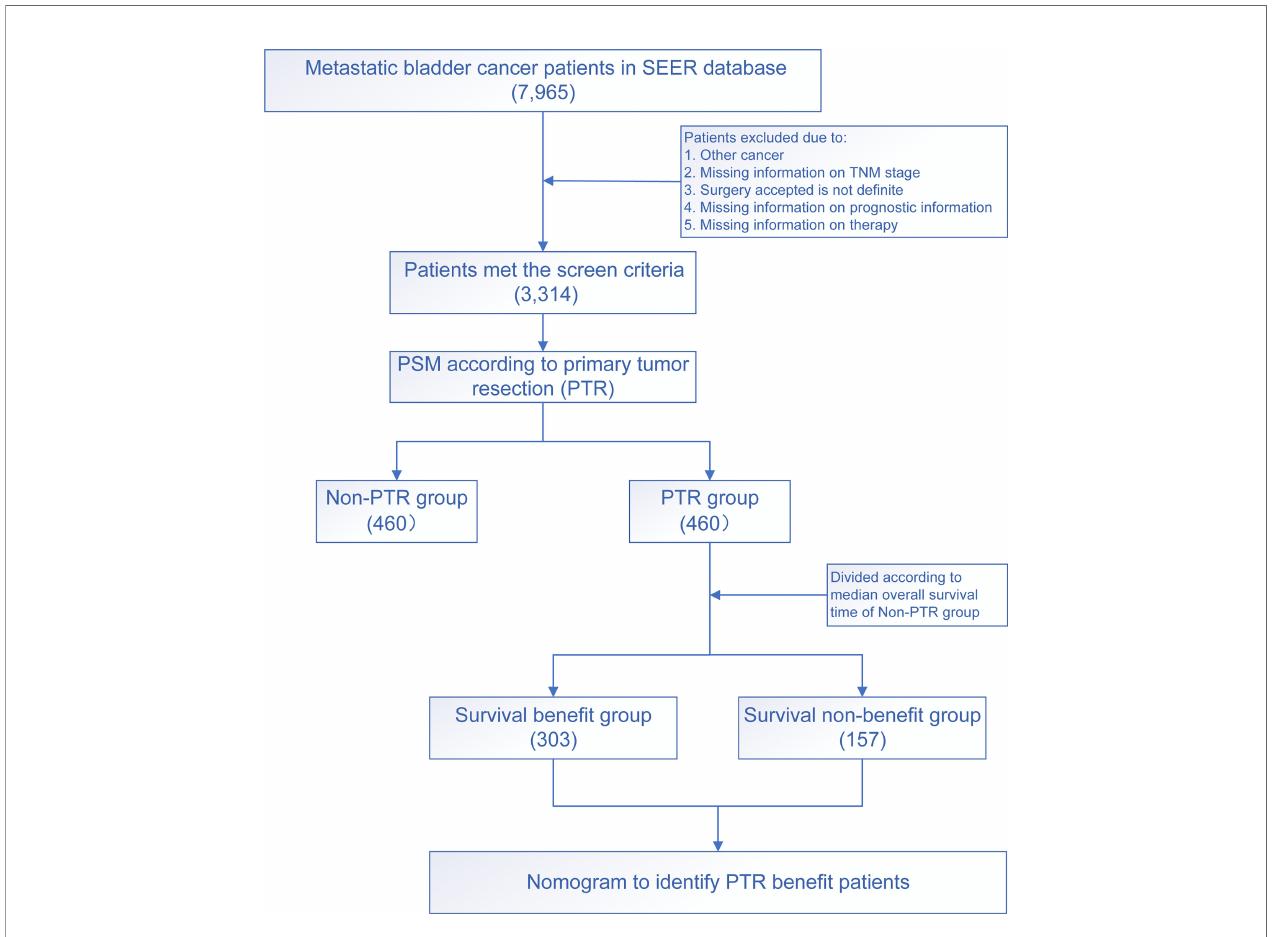
FIGURE 1 | The fl owchart of the